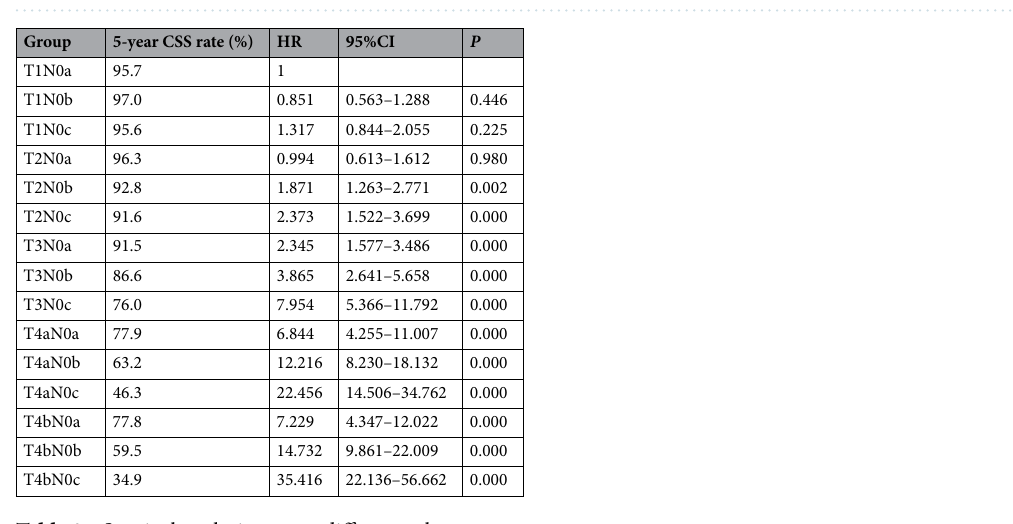
Table 3. Survival analysis among different